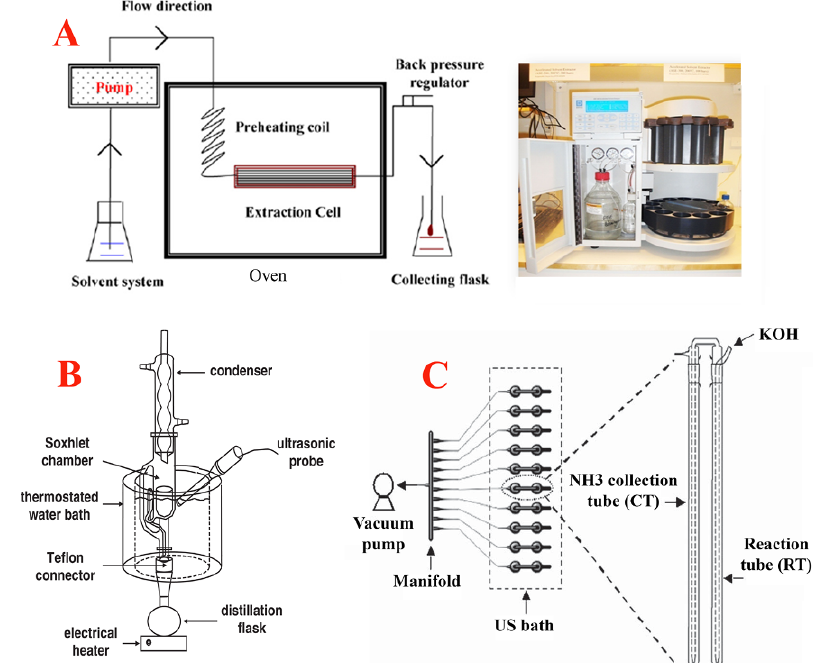
Figure 8. Scheme of (A) an accelerated solvent extraction system, (B) an ultrasound assisted Soxhlet leacher and (C) an ultrasound assisted purge and trap system (reproduced with permission of Elsevier [